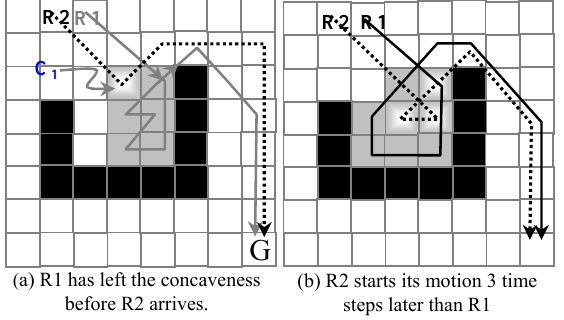
Fig. 8. Applying the modified algorithm for multi-robot